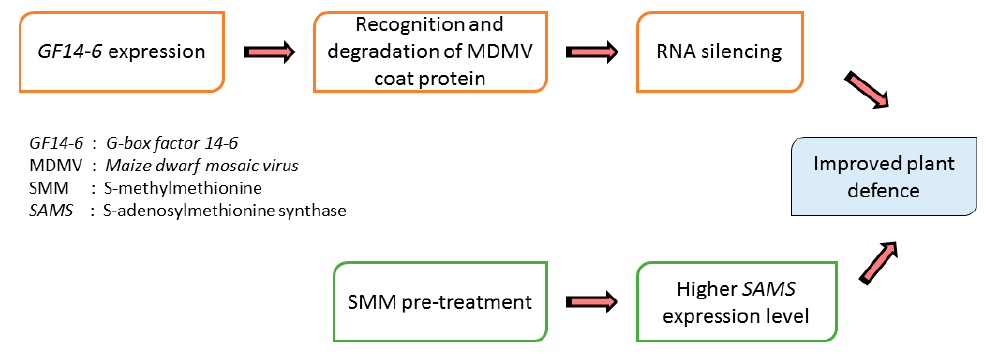
Figure 4. Effects of S-methylmethionine application on GF14-6 and S-adenosylmethionine synthase (SAMS) expression level in MDMV infected maize plants.